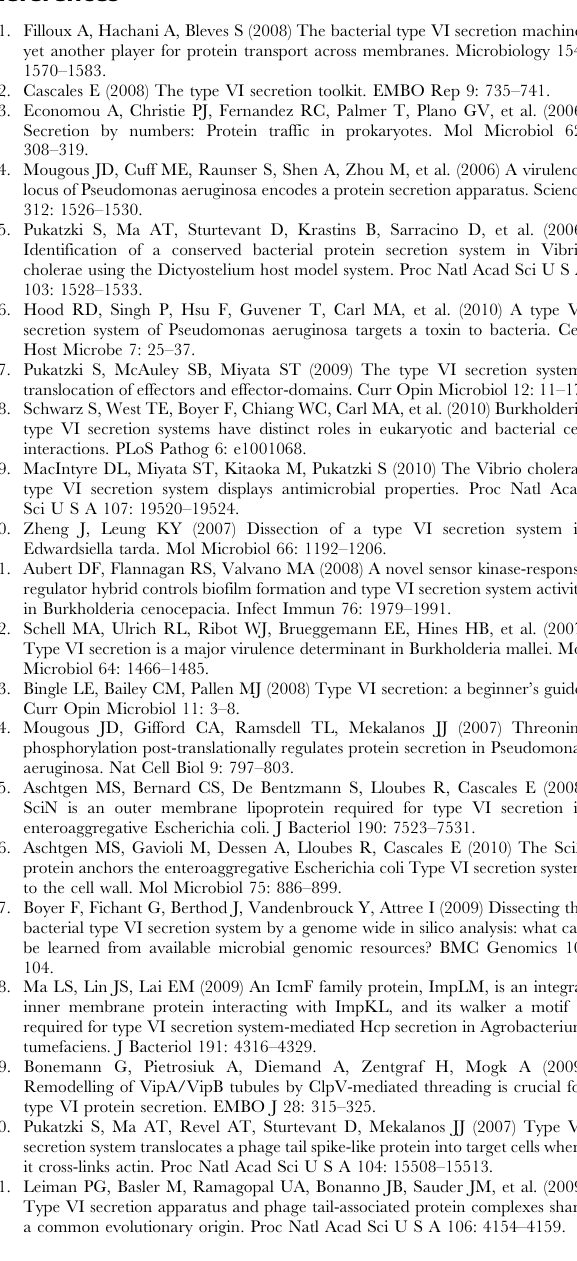
Table S1 Properties of proteins encoded in vgrG-1 and vgrG-2 putative operons. Table S2 The first ten hits of VCA0020 analyzed by HHPRED.